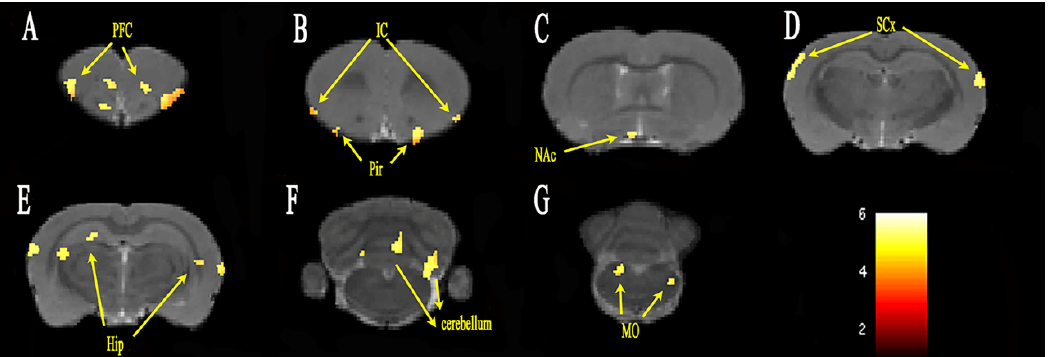
Figure 3. FC alterations in specific brain regions of PHN rats on day 14 ( A – G ). ROI heat maps show the brain regions with significantly increased FC. The color scale bar is shown in lower ‐ right part, with corrected t ‐ values ranging from 2 to 6. PFC, prefrontal cortex; IC, insular cortex; Pir, piriform cortex; NAc, nucleus accumbens; SCx, sensory cortex; Hip, hippocampus; MO, medulla oblongata; cerebellum. Table 2. The group differences of FC changes between PHN group and CON group on day 14. Coordinates of Peak